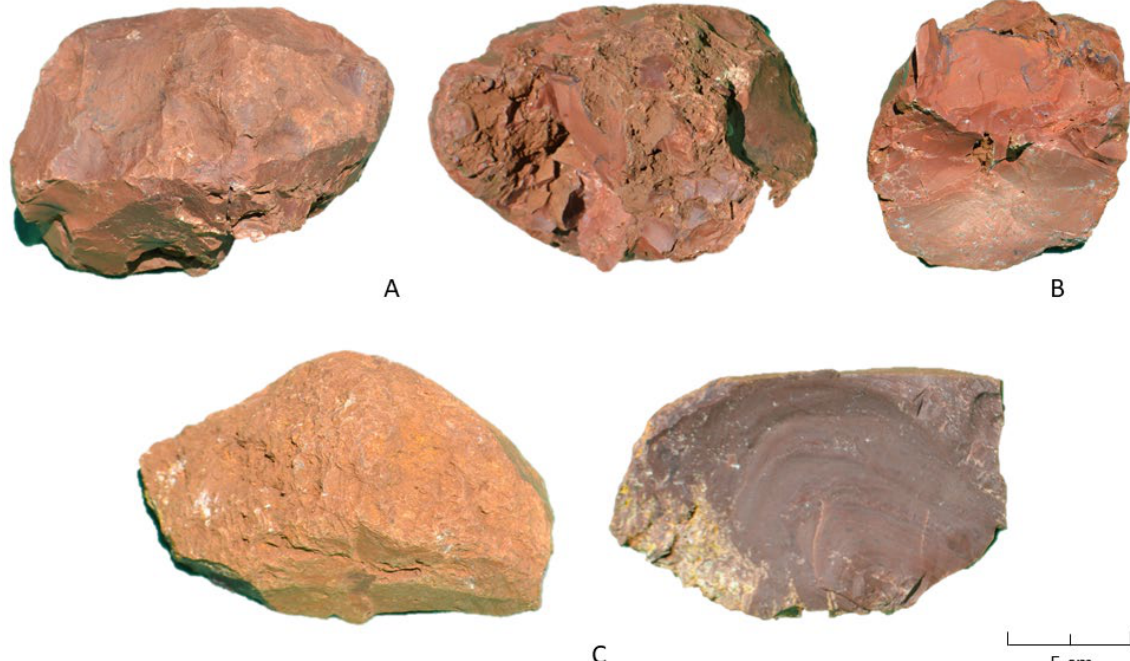
Figure 15. Non-translucent cherts recovered from the riversides during the survey. Upper line: pebble (probably from tabular clast) of reddish chert. A: external views. B: fractured by percussion. C: pebble of brownish-reddish chert. Left: external view; right: fractured by